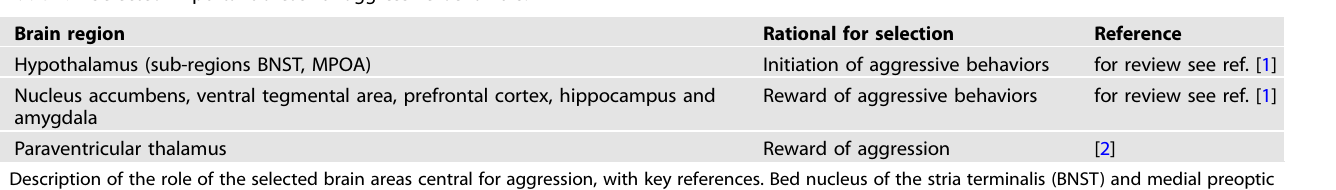
Table 1. Selected important areas for aggressive behaviors.